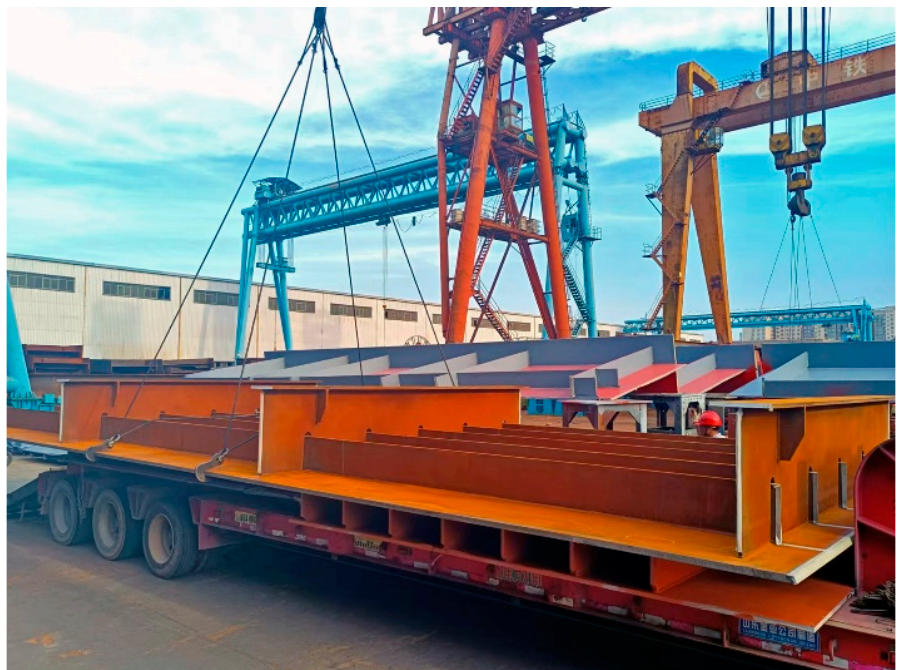
Figure 1. Orthotropic steel deck of weathering